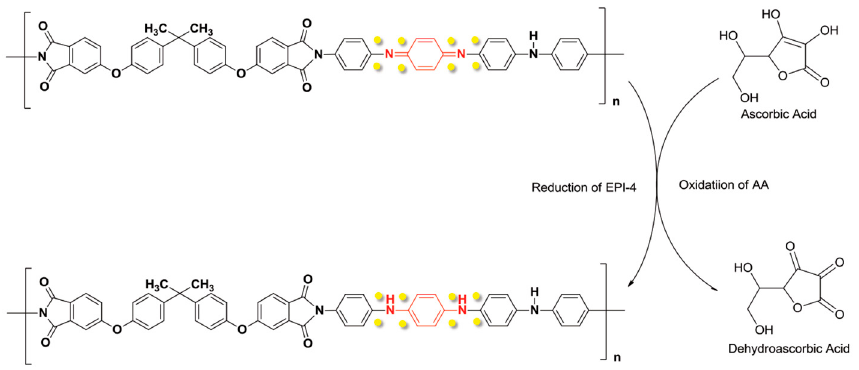
Figure 15. Scheme of EPI-4 structure used into a CPE to determinate AA. Yellow points represent gold nanoparticles. Reproduced with permission from [155]. Copyright 2017 Elsevier.